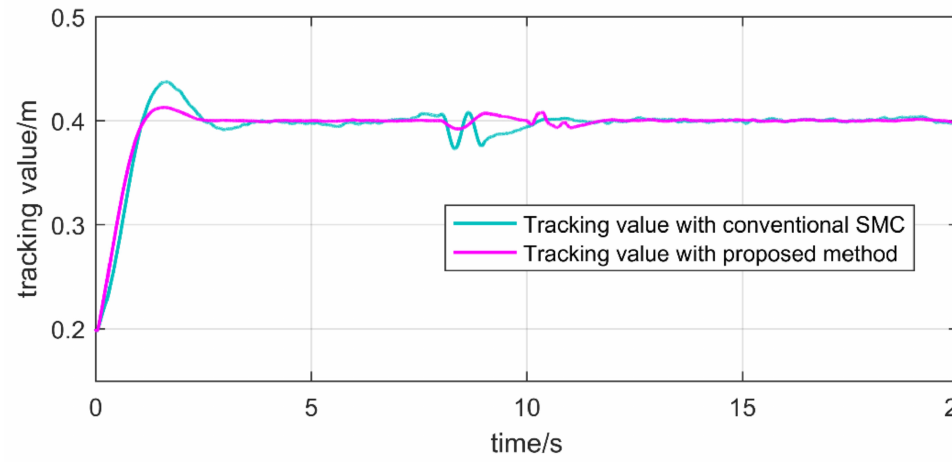
Figure 5. Trajectory tracking of position y .